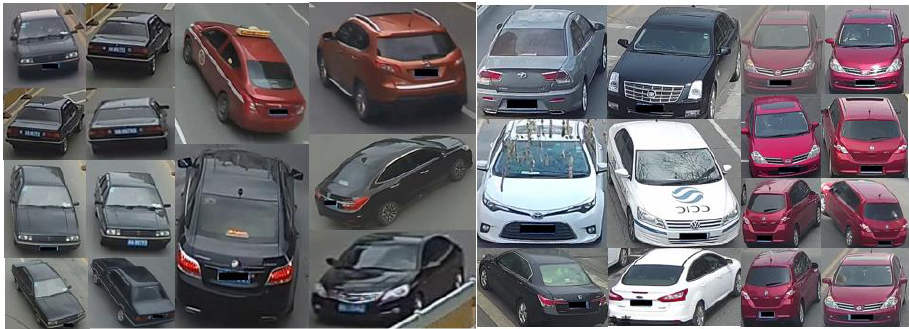
Figure 9. Examples of images from the VeRi dataset [67] and VeRi-Wild [55].